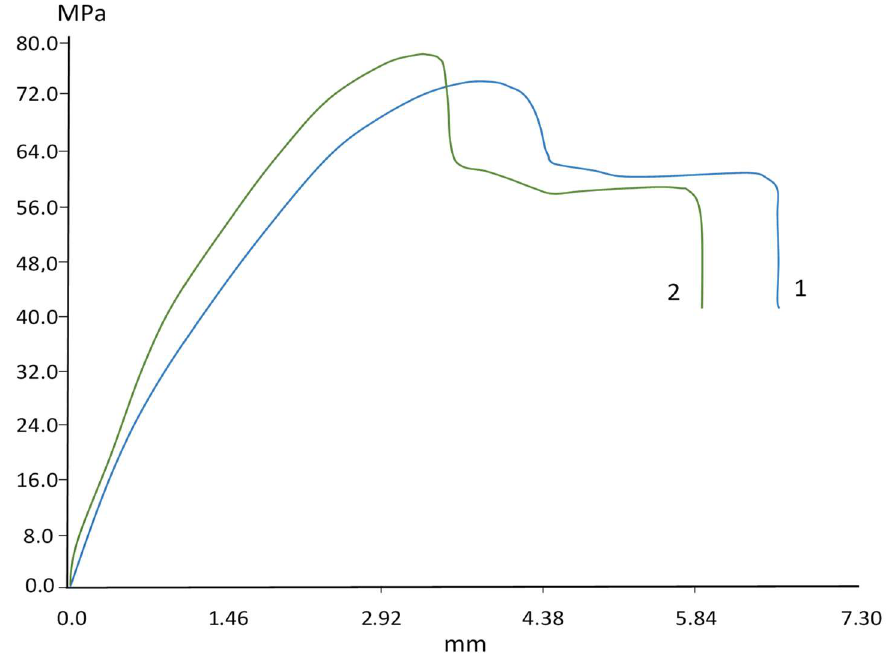
Figure 6. Stress-strain curves: 1—PPSU-17; 2—PPSU-3/n/f.